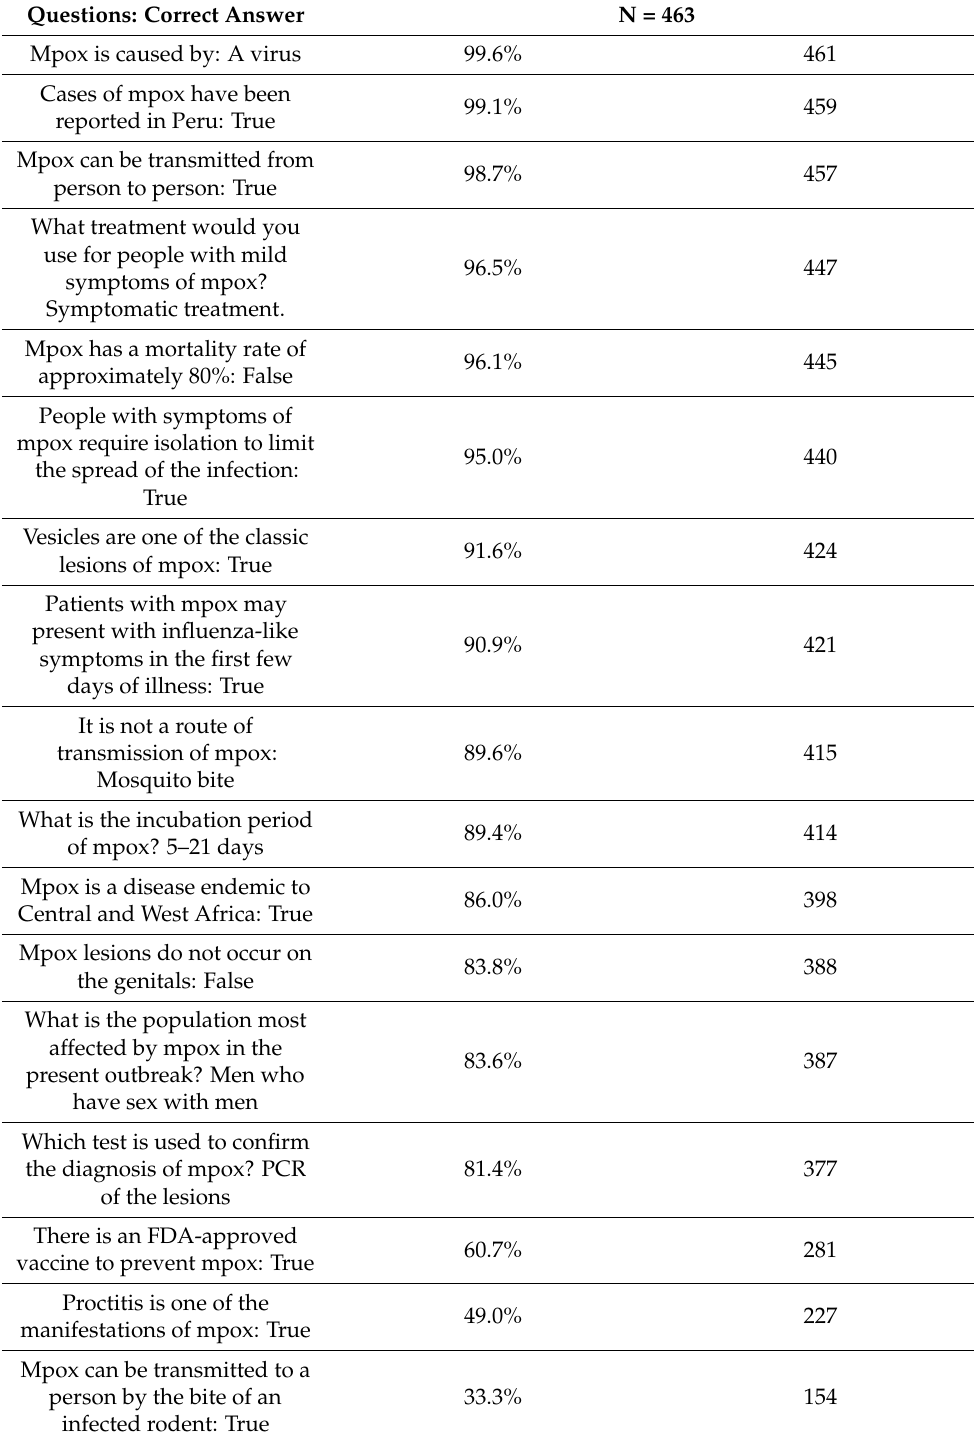
Table 2. Proportion of correct answers by